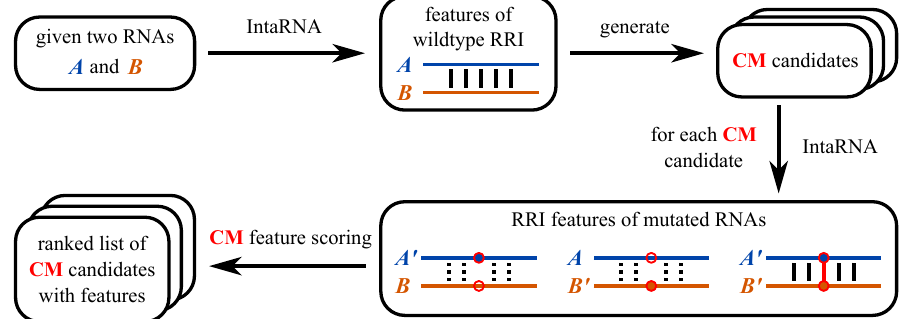
Figure 2. Workflow of CopomuS to generate and rank CoM candidates based on IntaRNA RRI predictions and respective